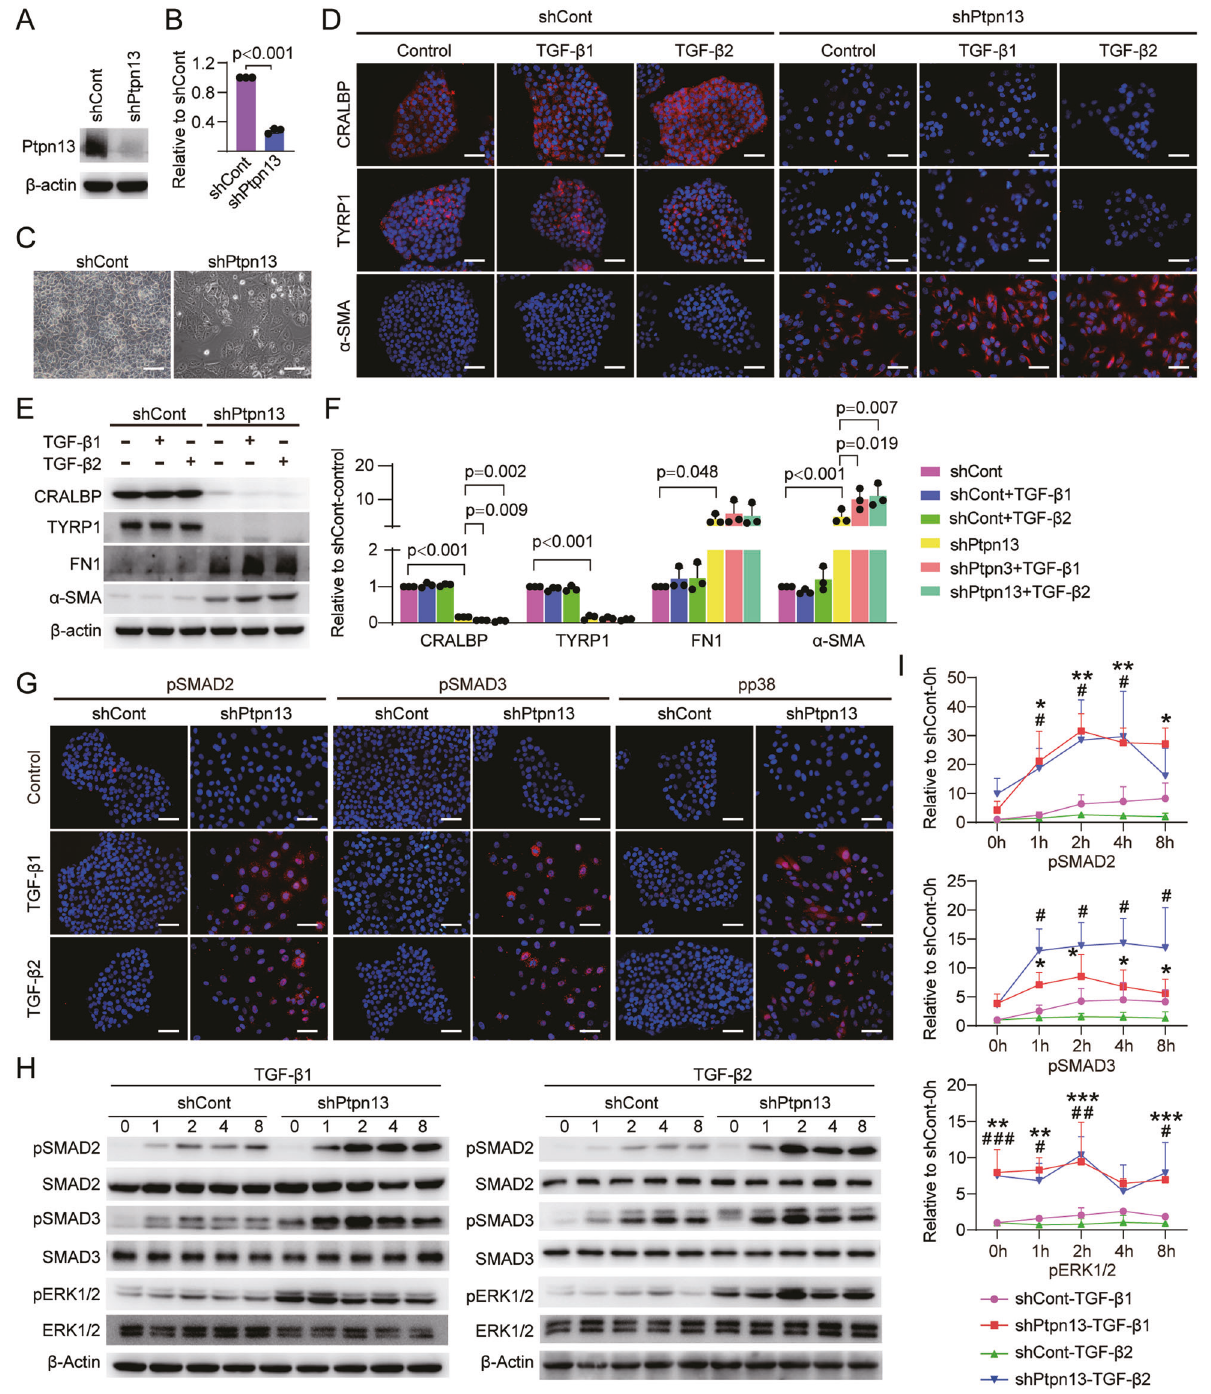
Fig. 4 PTPN13 confers TGF- β -induced EMT Resistance on iRPE cells. The expression level of PTPN13 in shCont-iRPE and shPtpn13-iRPE cells were detected by A Western blotting and B quantitative analysis ( n = 3, P value measured by Student ’ s unpaired t test). C Representative images of shCont-iRPE and shPtpn13-iRPE cells. RPE-speci fi c and EMT-associated markers in shCont-iRPE cells and shPtpn13-iRPE cells stimulated with TGF- β 1 or TGF- β 2 were detected by D immunostaining, E Western blotting, and F quantitative analysis ( n = 3, P value measured by one-way ANOVA and post hoc Bonferroni ’ s test). Phosphorylation of SMAD2/3, p38, and ERK1/2 in shCont-iRPE and shPtpn13- iRPE cells were analyzed by G immunostaining, H Western blotting, and I quantitative analysis ( n = 3, P value measured by one-way ANOVA and post hoc Bonferroni ’ s test). Scale bar = 50 μ m. Results are expressed as mean ± SD. * P < 0.05, ** P < 0.01, *** P < 0.001, shPtpn13-TGF- β 1 compared with shCont-TGF- β 1; # P < 0.01, ## P < 0.01, ### P < 0.001, shPtpn13-TGF- β 2 compared with shCont-TGF- β 2.